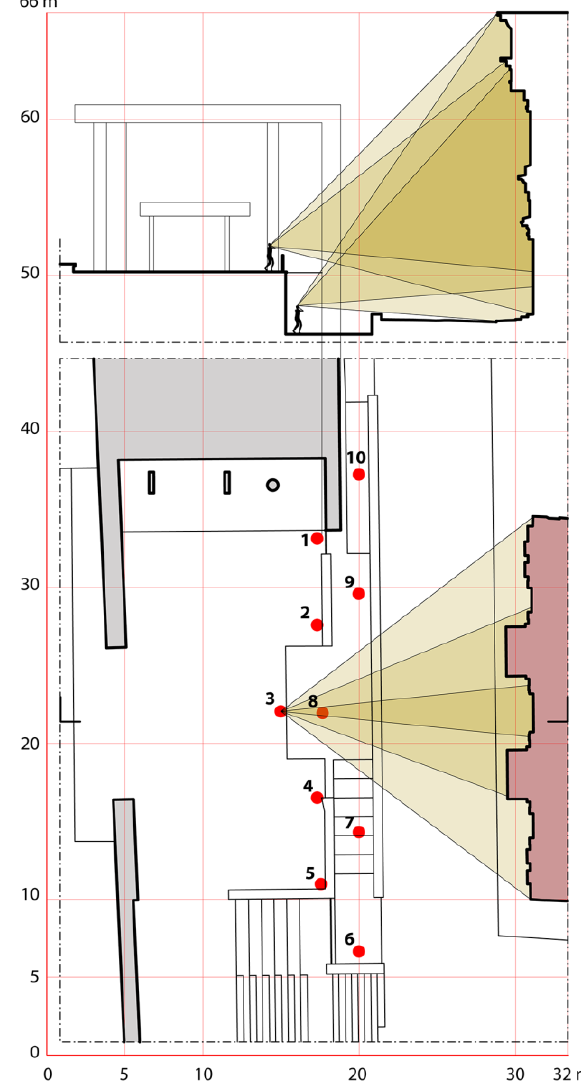
Figure 4. Photogrammetric survey schema. The plan shows the cameras acquisition network and the horizontal image rotation from point of view #3; in section a pair of acquisition points whit vertical baseline and rotation with 2 images.